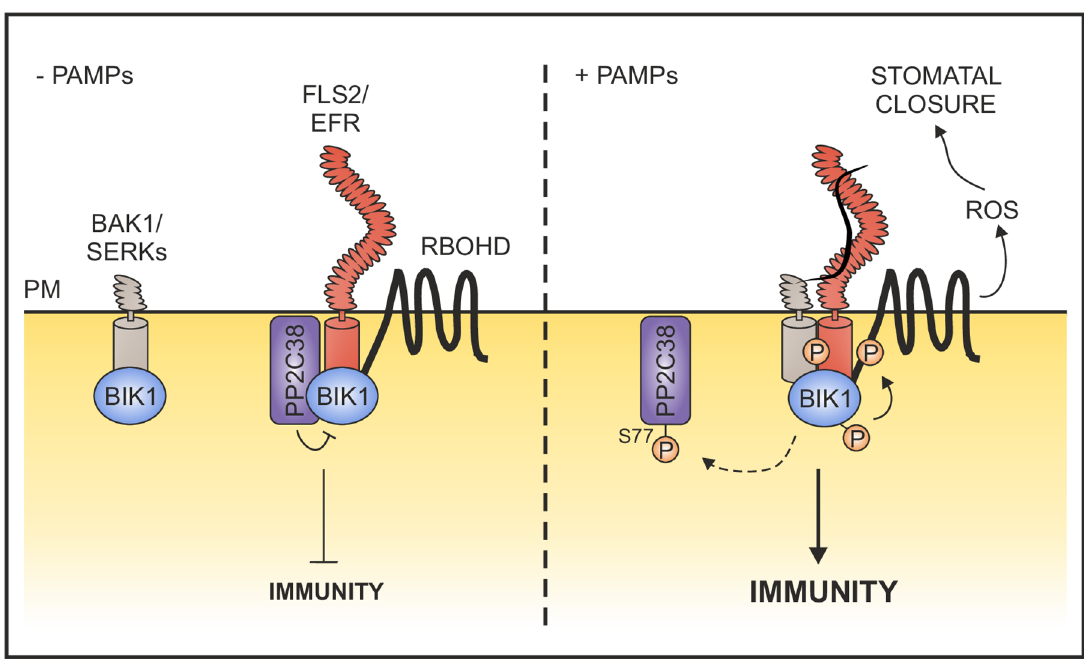
Fig 7. Model: PP2C38 dephosphorylates BIK1 to attenuate innate immune signalling. In the absence of pathogen elicitation, PP2C38 associates with PRR-BIK1 complexes to dephosphorylate BIK1 and prevent its activation. Upon PAMP perception, BAK1 is recruited and trans-phosphorylation of the PRR complex triggers BIK1 hyper-phosphorylation. In turn, activated BIK1 presumably phosphorylates PP2C38 on S77 to enable its dissociation from the PRR complex. The release of PP2C38 relieves the negative regulation imposed on BIK1, allowing efficient subsequent activation of downstream targets.